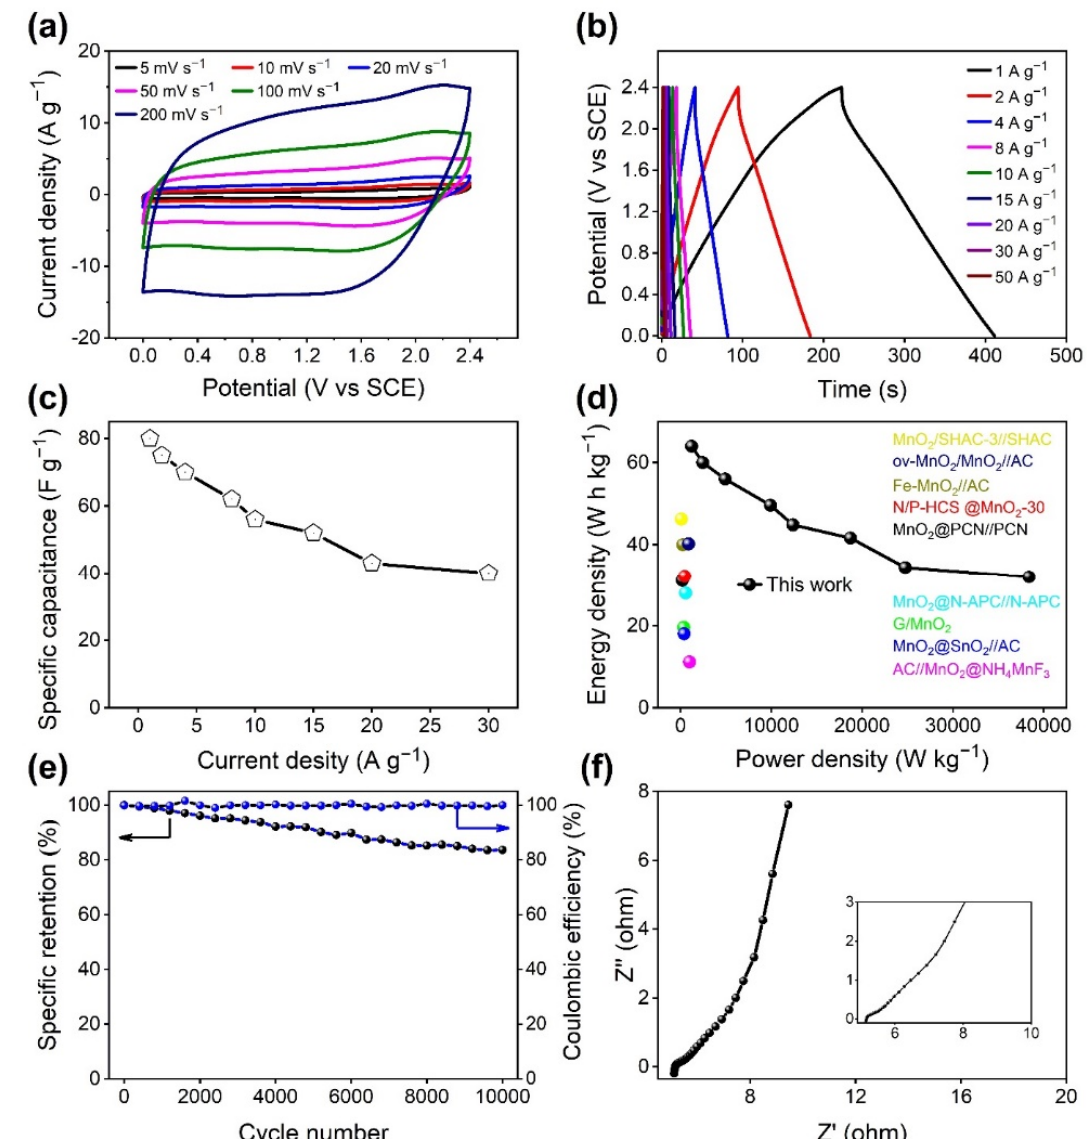
Figure 6. Electrochemical performance of Na 3 -MnO 2 //N-AC device ( a ) CV curves at 5, 10, 20, 50, 100, and 200 mV s −1 scan rate and 0–2.4 V potential window; ( b ) GCD curves at 1, 2, 4, 8, 10, 15, 20, 30, and 50 A g −1 current densities and 0–2.4 V potential window; ( c ) Specific capacitance at various current densities of 1, 2, 4, 8, 10, 15, 20, and 30 A g −1 current densities ( d ) Ragone plot of the gravimetric energy density and power density comparison of this work Na 3 -MnO 2 //N-AC device and other previously reported works; ( e ) The cycling stability and Columbic efficiency at 10 A g −1 ; ( f ) EIS. CV curves of Na 3 -MnO 2 //N-AC device at various scan rates (5, 10, 20, 50, 100,